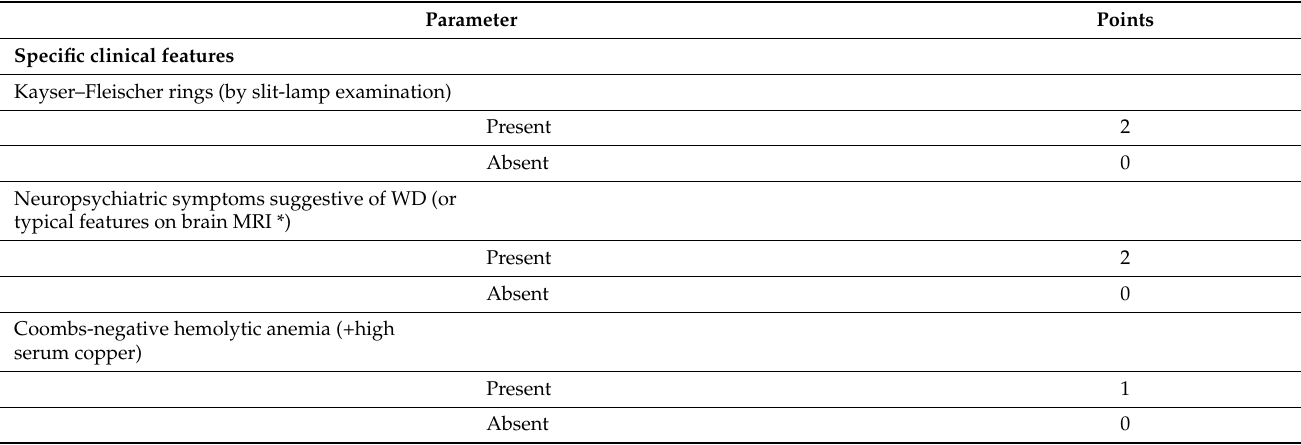
Table 1. Leipzig score (a scoring system for the diagnosis of Wilson disease).